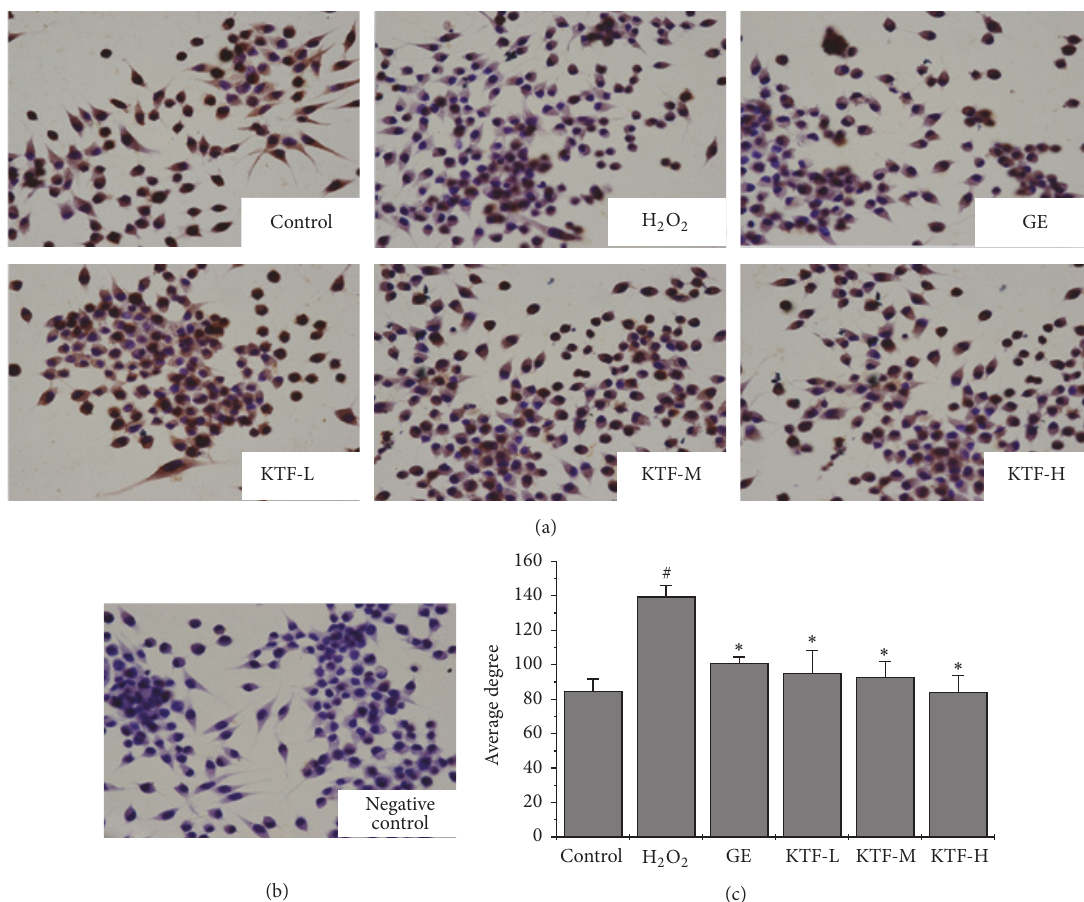
Figure 3: KTF ameliorated H 2 O 2 -induced reduction of TH in MES23.5 cells. Cells were fixed with 4% paraformaldehyde and the expression of TH was detected by immunocytochemistry. (a) Tan represents the TH positive expression ( × 400). (b) Negative control. (c) Results are expressed as average grey degree. Data are mean ± SD in three independent experiments. # 𝑃 < 0.05 compared to the control group. ∗ 𝑃 < 0.05 compared to the H 2 O 2 -treat